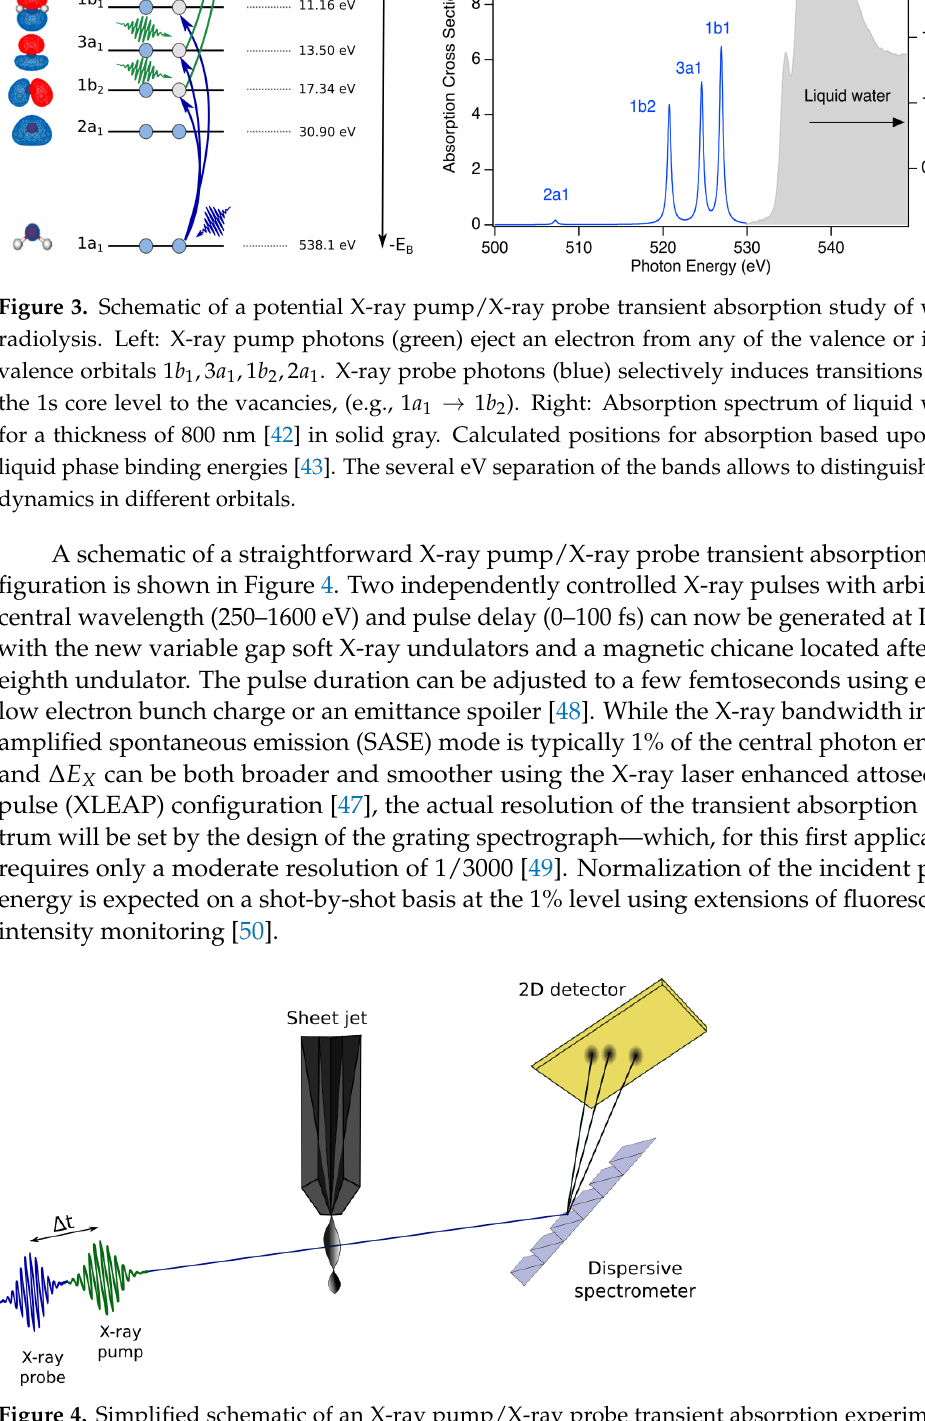
Figure 4. Simplified schematic of an X-ray pump/X-ray probe transient absorption experimental setup to study water radiolysis. Two broad bandwidth X-ray pulses, pump (green) and probe (blue) are produced collinearly from the accelerator and overlapped in a thin liquid sheet jet. Pump/probe delays between 0–100 fs are set with attosecond precision by the magnetic chicane. The transmitted beam is energy dispersed with a grating and detected on a 2D pixel